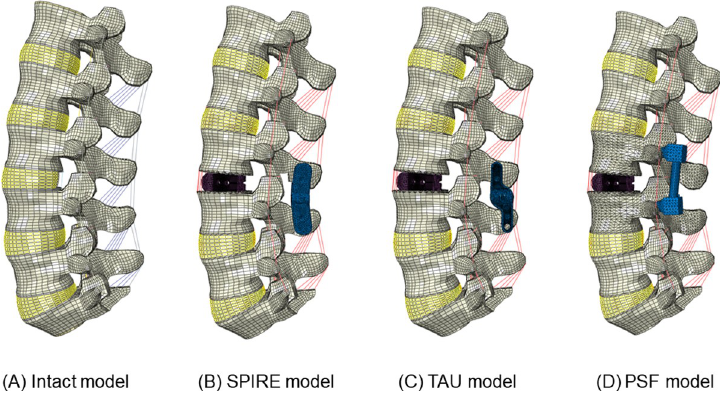
Fig 1. Finite element model of the intact and implanted lumbar spine: (A) Intact model, (B) SPIRE model with interbody cage, (C) TAU model with interbody cage, (D) Pedicle screw fixation model with interbody cage.